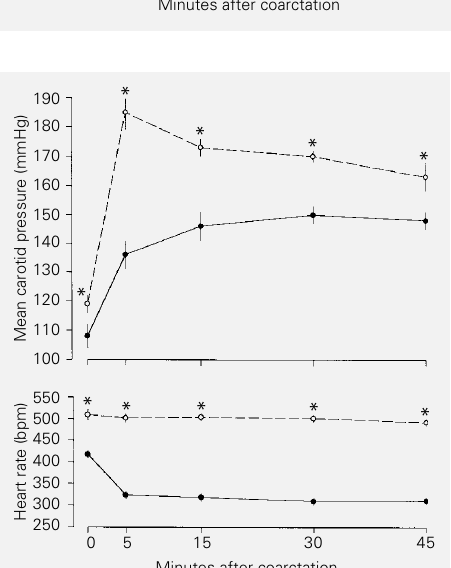
Figure 2 - Mean carotid pressure (upper panel) and heart rate (lower panel) responses to acute aortic coarctation in conscious unrestrained intact (continuous line) and sinoaortic denervated (SAD) (broken line) rats. Data are reported as means ± SEM. *P<0.05 compared to the corre- sponding point in the intact group (Student t